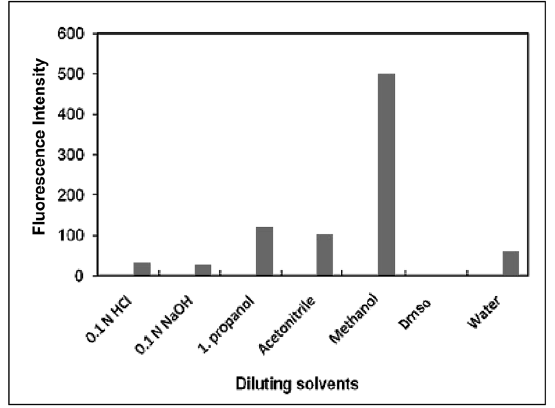
Fig.2. Excitation and Emission spectra of baricitinib in methanol at (λex 224) and (λem 414), respectively using the proposed spectrofluorometric method.